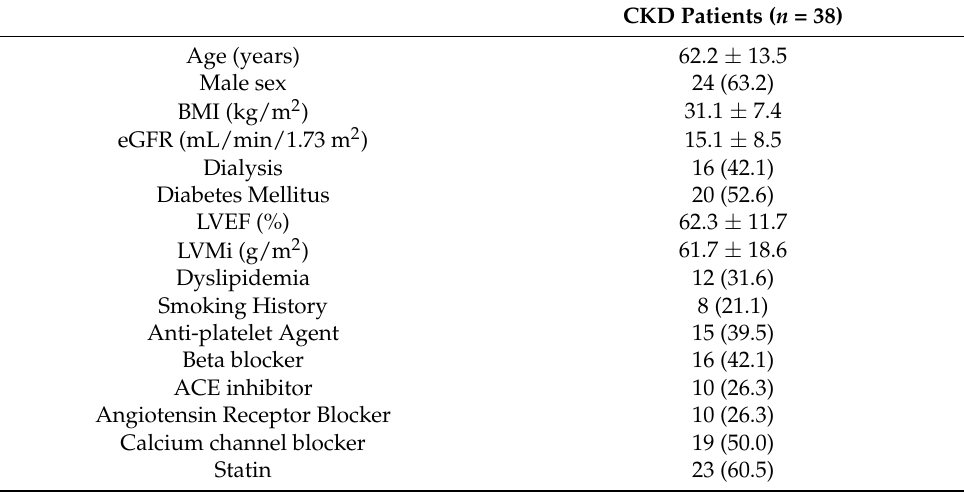
Table 2. Baseline